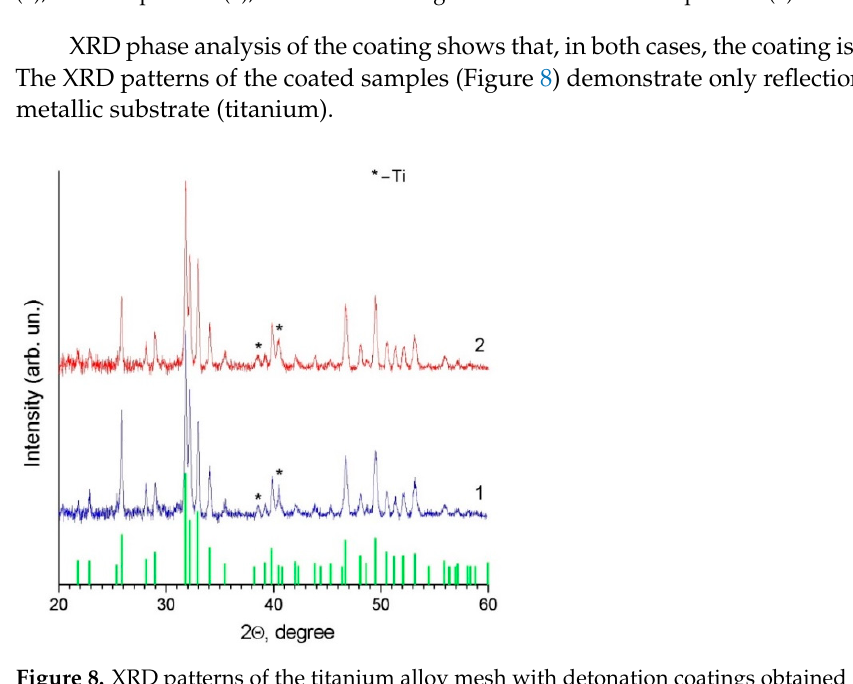
Figure 8. XRD patterns of the titanium alloy mesh with detonation coatings obtained from nano-HA (1) and calc-HA (2). Bar chart corresponds to PDF file 40-11-9308 (ICDD PDF-4) of crystalline HA.